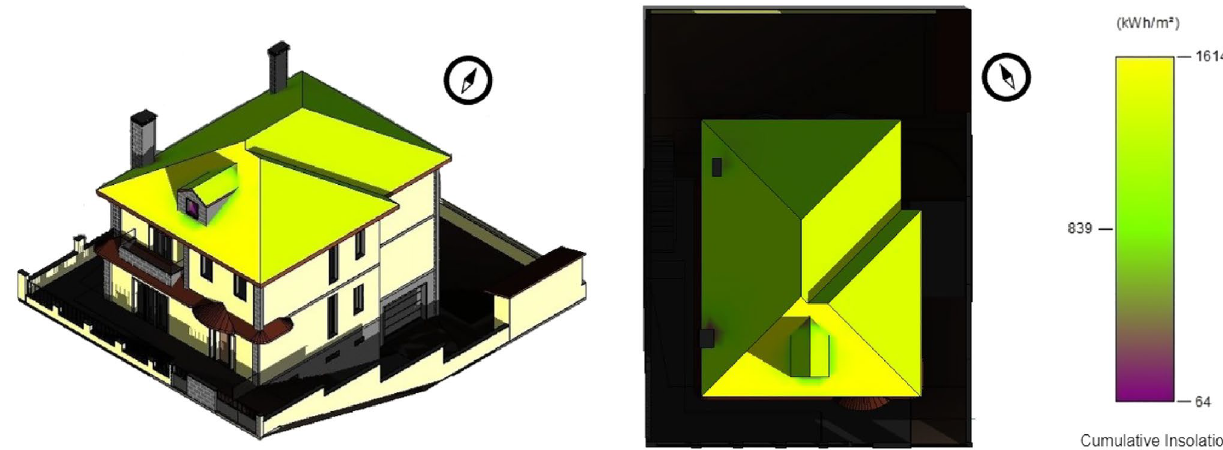
Fig. 4 Simulation results: 2021’s annual cumulative insolation